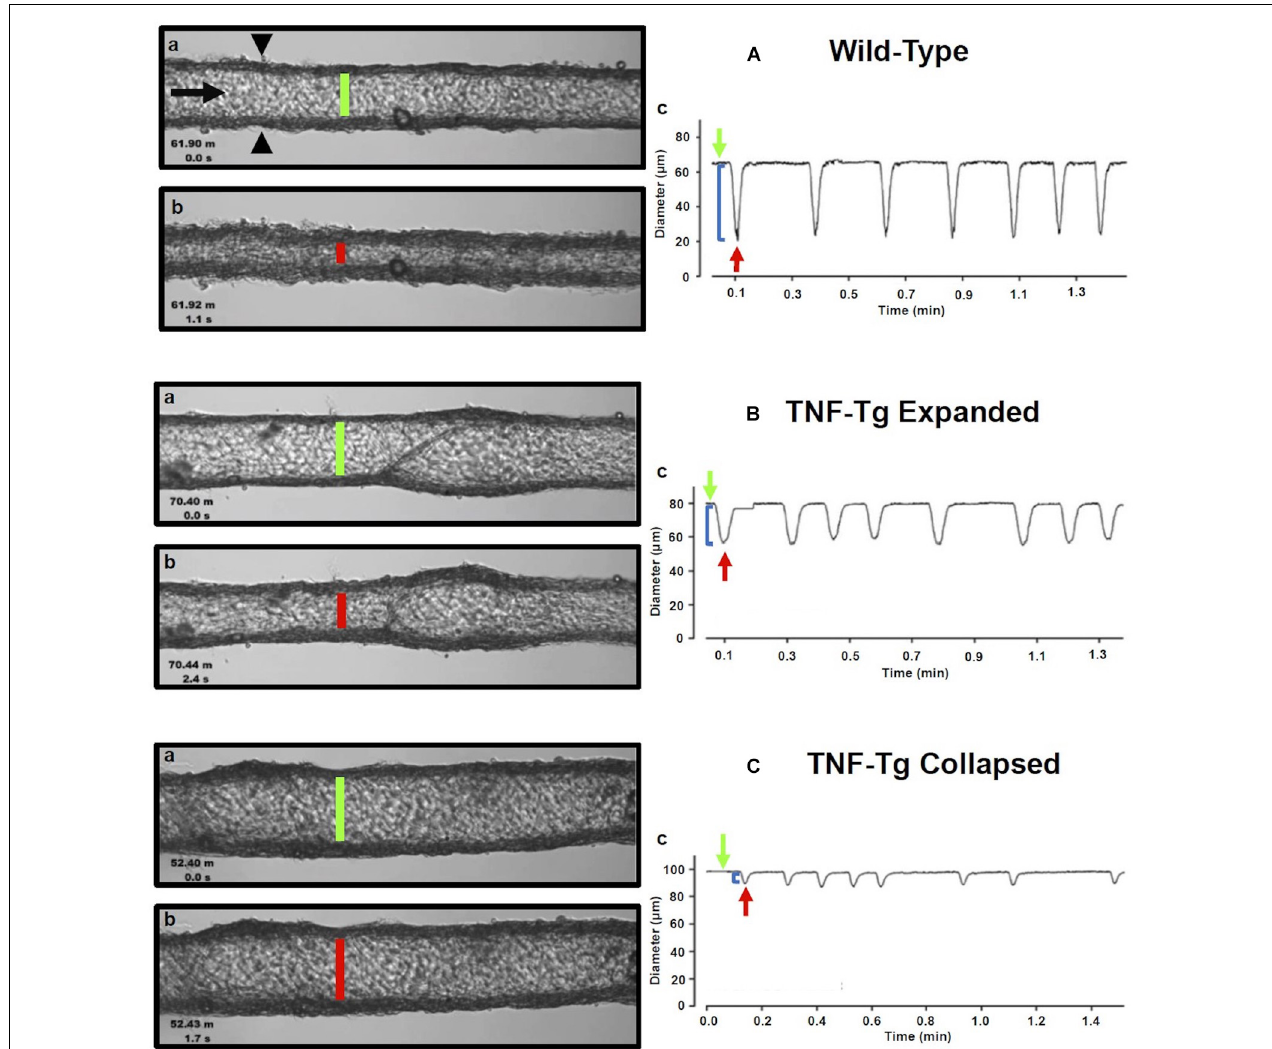
FIGURE 1 | Isolated popliteal lymphatic vessels from TNF-Tg mice exhibit a progressive reduction in contractility. Popliteal lymphatic vessels (PLVs) were harvested from wild-type (age-matched littermates) (A) and TNF-Tg mice with expanded (4–5-months-old) (B) and collapsed (9–11 months-old) (C) popliteal lymph nodes ( n = 5 mice per group). The PLVs were then cannulated with constant fluid flow into the lumen of the vessel (black arrow) to measure spontaneous PLV contractions by assessing changes in diameter between the vessel walls (black arrowheads) (Aa) . In each condition, representative PLVs are shown in diastole (A–Ca) and systole (A–Cb) with quantified changes in diameter representing contractions (local minima) over time under constant pressure (3 cmH 2 O) (A–Cc) . Note the increase in end diastolic diameter (EDD; green lines) and end systolic diameter (ESD; red lines) in TNF-Tg PLVs (expanded < collapsed) compared to wild-type PLVs (A–Ca,b) . The change in EDD (green arrows) and ESD (red arrows) represents a reduction in contraction amplitude (blue brackets) in TNF-Tg PLVs (expanded > collapsed) relative to wild-type control PLVs (A–Cc)